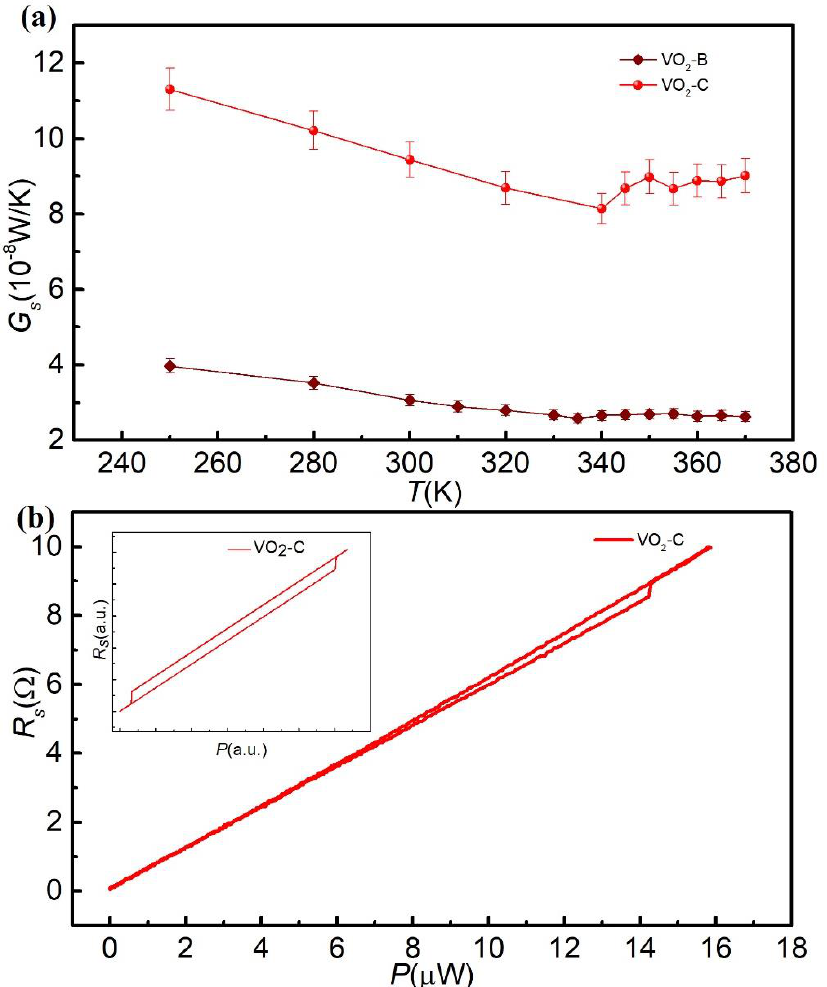
Figure 2. ( a ) The thermal conductance as a function of temperature for VO 2 -B and VO 2 -C, respectively. ( b ) The electrical resistance of the sensor as a function of the heating power using the thermal bridge method at T = 335 K. The inset shows the simulation results of electrical resistance of sensor as a function of the heating power in the thermal bridge method at T = 335 K.